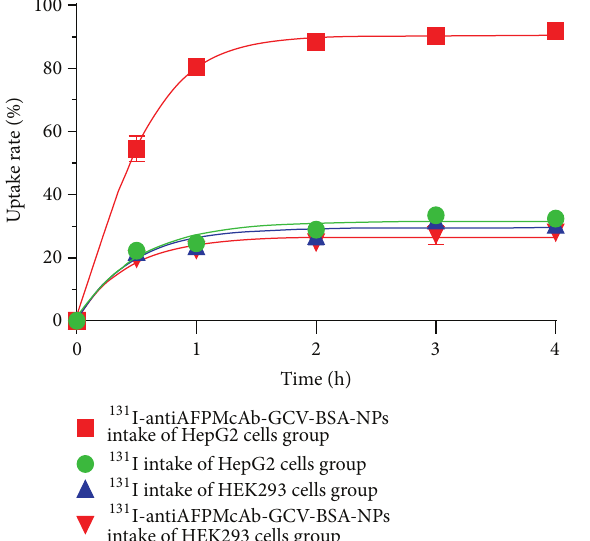
Figure 4: Retention curves of 131 I and 131 I-antiAFP-GCV-BSA- NPs in HepG2 cells and HEK293 cells. The radioactive retention ratesof 131 I-antiAFPMcAb-GCV-BSA-NPs inHepG2 cellsgroup are obviously higher than those of other three groups at the same time